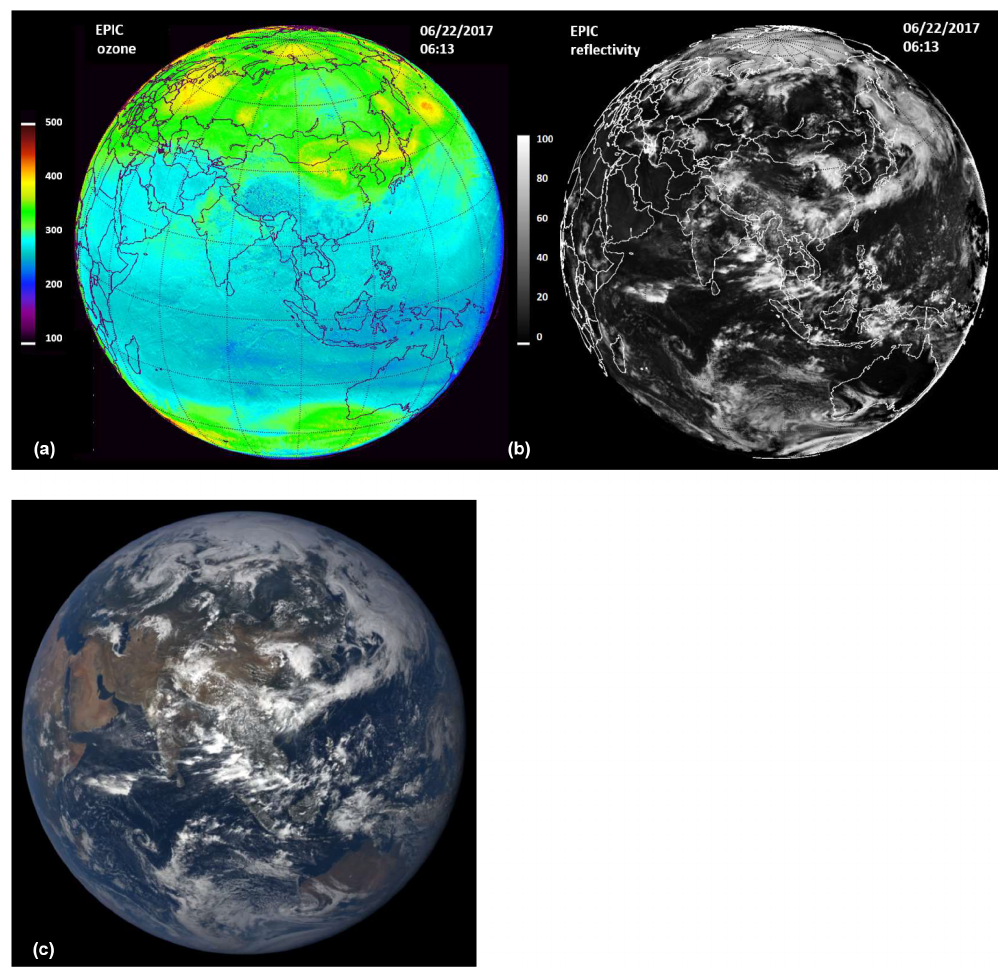
Figure 9. EPIC-derived TCO 3 (upper left in DU: 100 to 500DU) and reflectivity (LER upper right in percent or RU: 0 to 100) for 22 June 2017 at t O = 06:13GMT. Lower left: color image of the Earth showing clouds and land areas. The brighter clouds are optically thick and correspond to the higher values of the LER. Figure map created with IDL ® . Color image available at https://epic.gsfc.nasa.gov/ (last access: 16 June